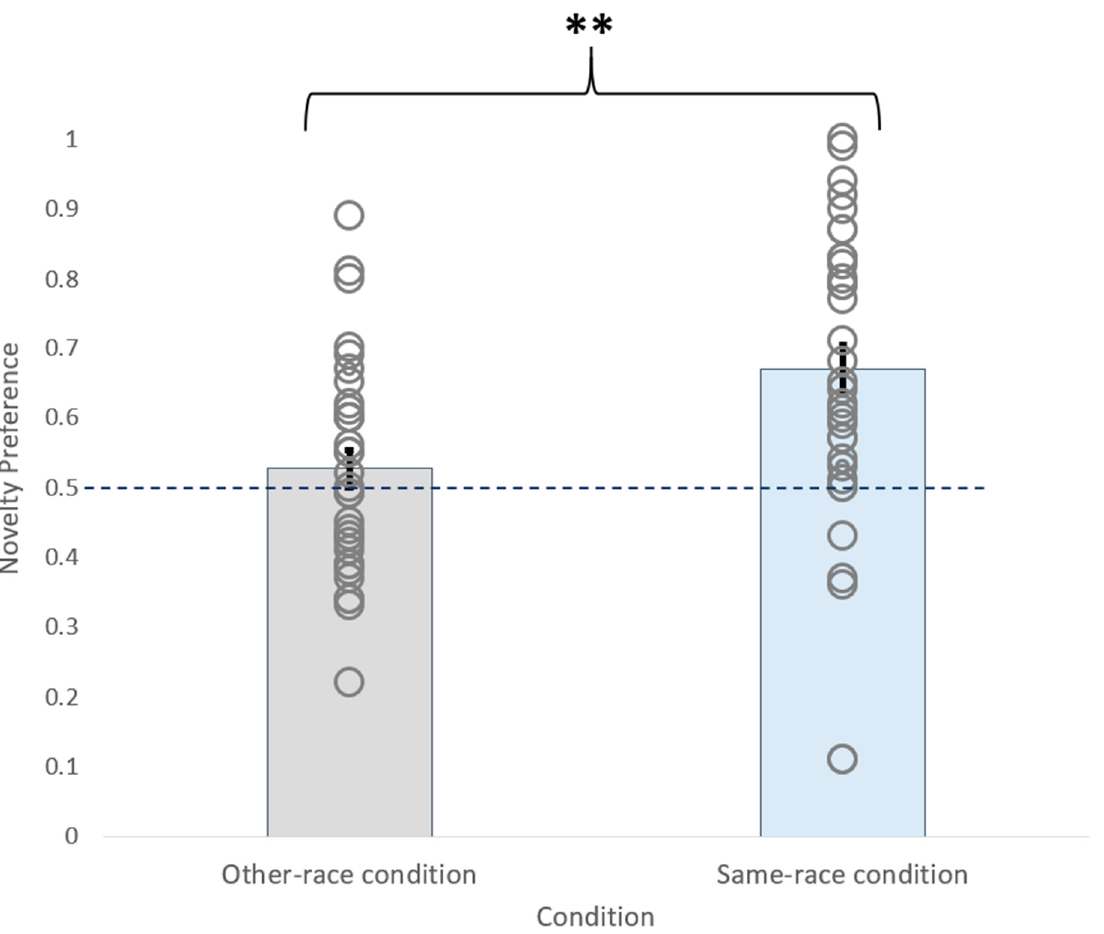
Figure 3. Novelty preference scores for the same-race and other-race conditions. Circles indicate the individual data points, and the dotted line indicates the expected chance-level novelty preference of 0.5. Error bars indicate standard error, and two stars indicate a significance level of p < 0.01.